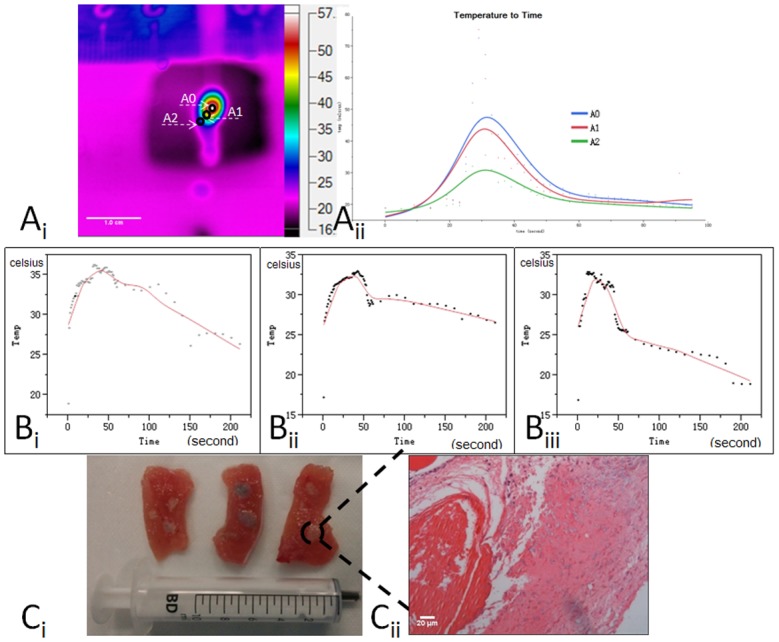
Temperature changes in spatial and temperal relationships during the injection of sodium-potassium alloy-oil mixture.Ai and Aii) Video stream of the thermal damage as acquired by the infrared Fluke Ti400 Thermal Imager. A0 to A2 indicates the temperature distribution (Ai) and alteration at different distances from the reaction center (Aii). The continuous region of interest selection A0, A1, A2, points in the tissue that the heat readings, and the distance from the center heat source are approximately 0mm (A0), 1mm (A1), 2mm (A2). Bi, Bii, Biii) Temperature to time curves were captured from three muscle strips corresponding to different ratios of a mixture of NaK and oil 1:10 (Bi), 1:5(Bii), and 1:2 (Biii) for the ablation of muscle with the same amount of NaK. C) From left to right, three muscle strips corresponding to different ratios of a mixture of NaK and oil (1:10, 1:5, and 1:2) for the ablation of muscle. Coming to each muscle stripe, three seperate ablation points with the same volume of the mixture. D) Effects of the NaK–oil mixture on muscle tissue and cells: apparent necrosis of a large number of muscle cells with the disappearance of cell structure and dissolved nuclei.